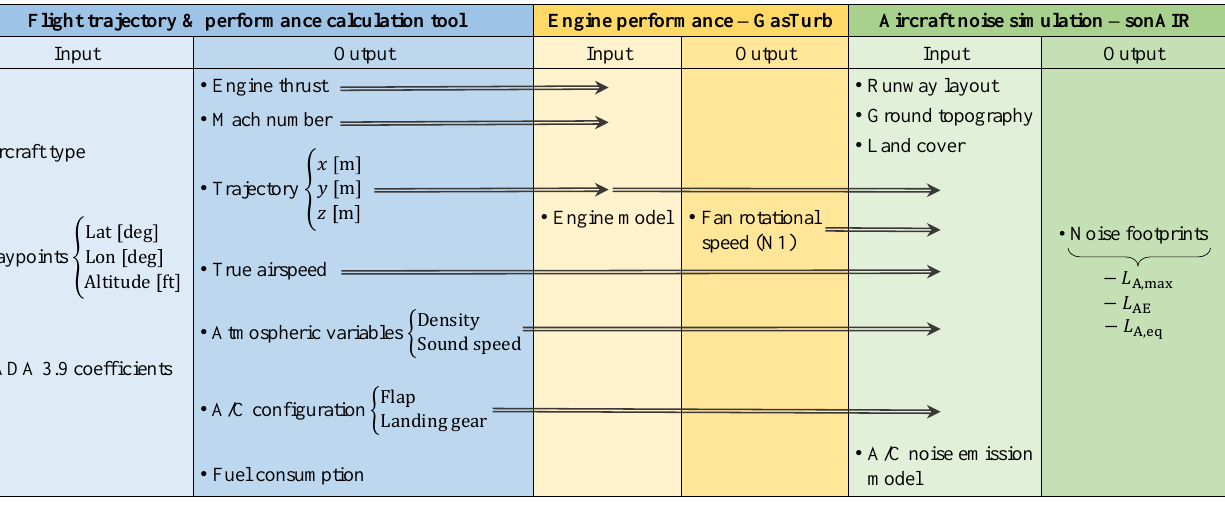
Figure 1. Schematic of the proposed multi-level simulation framework, including the inputs and outputs associated with the different prediction